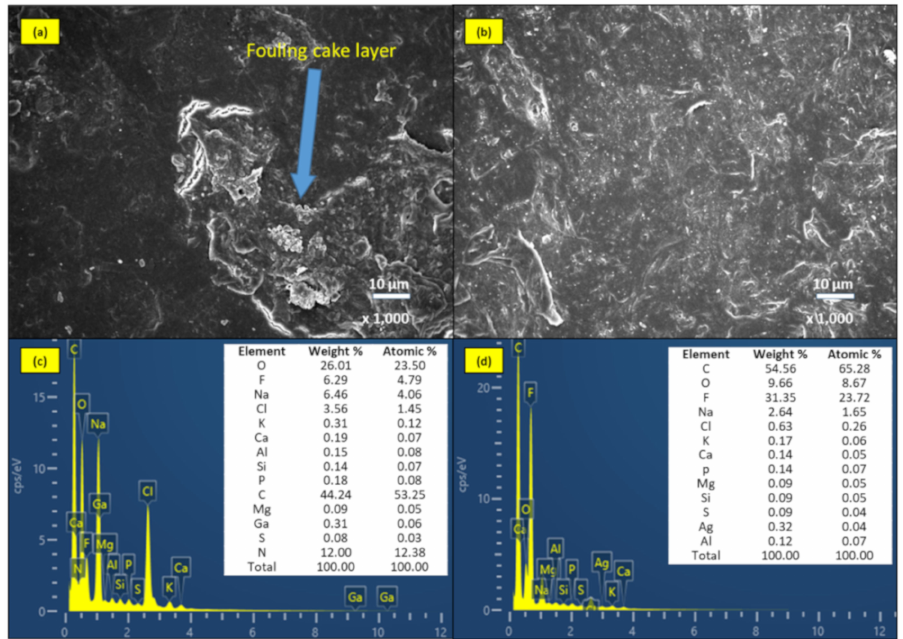
Figure 6. The images of SEM and EDS spectra of ( a , c ) unmodified membrane and ( b , d ) AgNPs-MF membrane after 60 days in operation